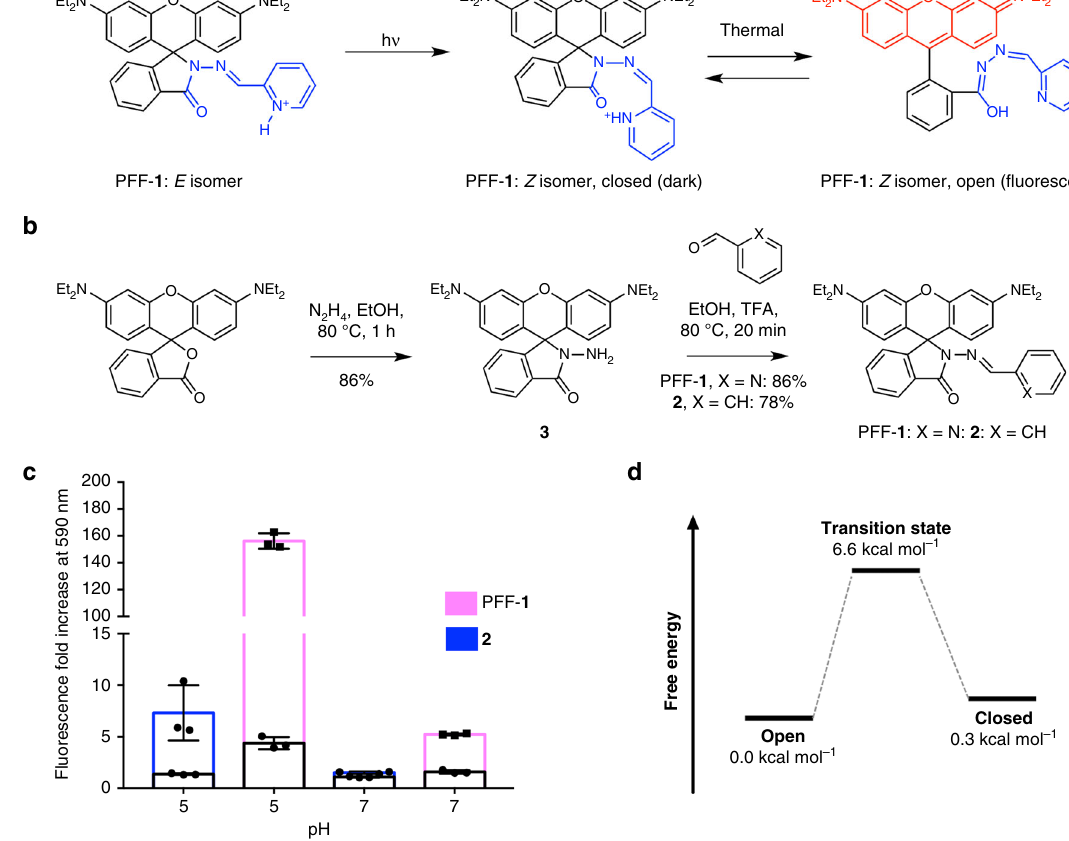
Fig. 2 Synthesis and mechanism of probe PFF- 1 . a Mechanism of photoactivation and fl uxionality of PFF- 1 . b Synthesis of probes PFF- 1 and 2 through their common intermediate 3 . c Fluorescence increase of compounds PFF- 1 and 2 upon photoirradiation at 410 nm in buffered aqueous solutions. Bars represent average values of three independent measurements ( N = 3) and error bars indicate standard deviation (±). d Calculated potential energy surface for ring opening of the Z isomer of probe PFF- 1 . The structures of “ open ” and “ closed ” correspond to those in panel ( a ). Relative energies were obtained at the B3LYP/def2-TZVP/IEFPCM(H 2 O) level of